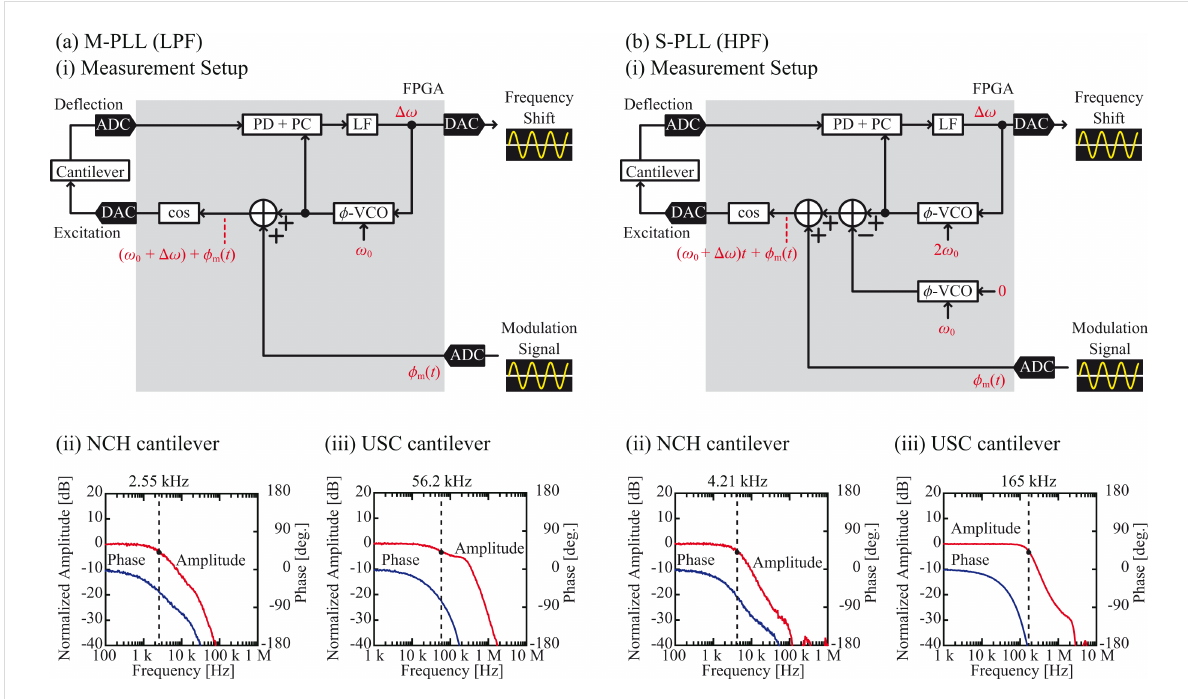
Figure 7: Performances of the (a) M-PLL with the LPF and (b) S-PLL with the HPF. (i) Block diagrams of the setups. (ii) and (iii) Frequency responses of the PLLs measured with the NCH ( f 0 = 151.46 kHz, k = 41.3 N/m and A = 0.1 nm) and USC ( f 0 = 3.44 MHz, k = 59.9 N/m and A = 0.1 nm) cantile- vers, respectively.